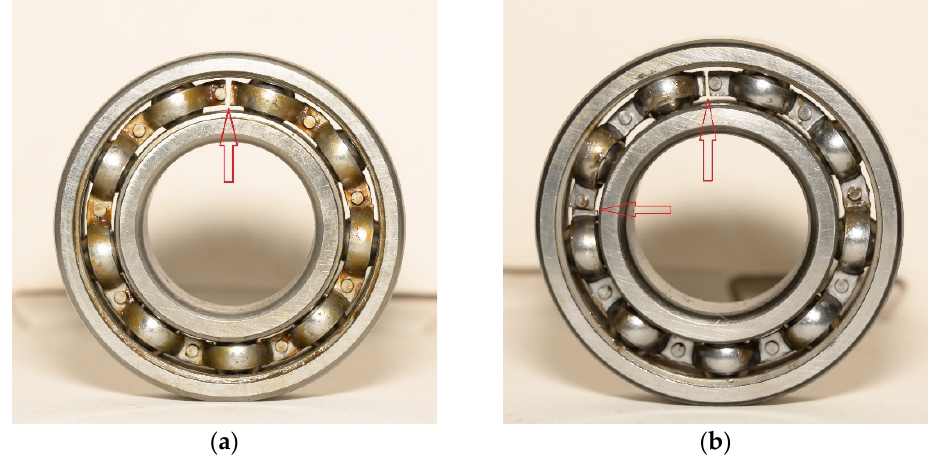
Figure 3. Faulty bearings (6206) with cage defects: ( a ) one gap and ( b ) two gaps.